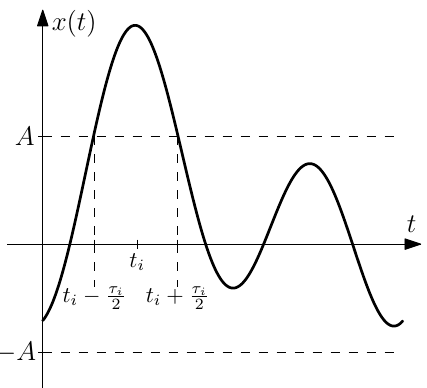
Figure 5. Exemplary representation of the i -th overshooting of the Gaussian distributed signal x on the clipping level A